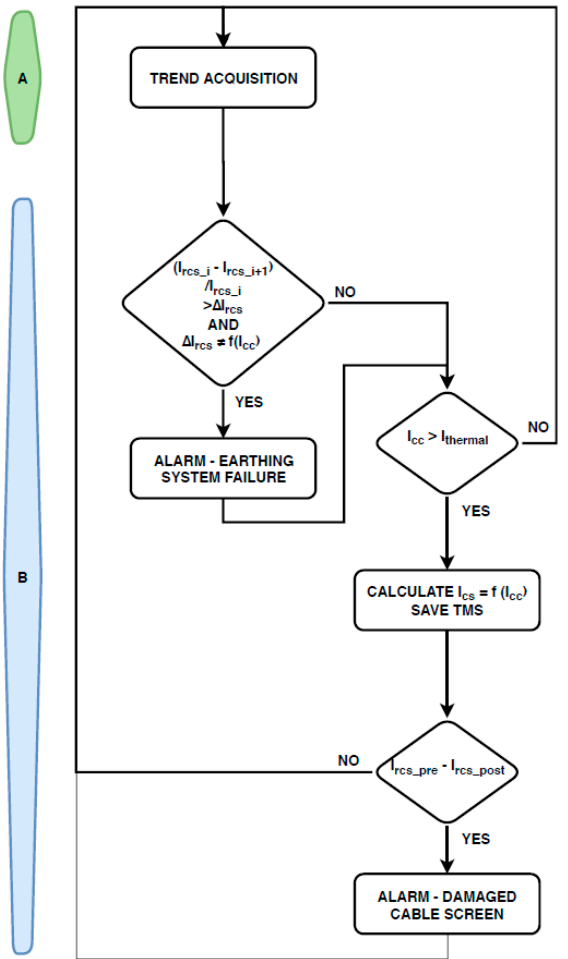
Figure 22. Algorithm for monitoring the thermo-mechanical stresses. I rcs_i/i+1 —consecutive measurements ; ∆ I rcs —setting of earthing system threshold; I cc —load current (phase values); I thremal —